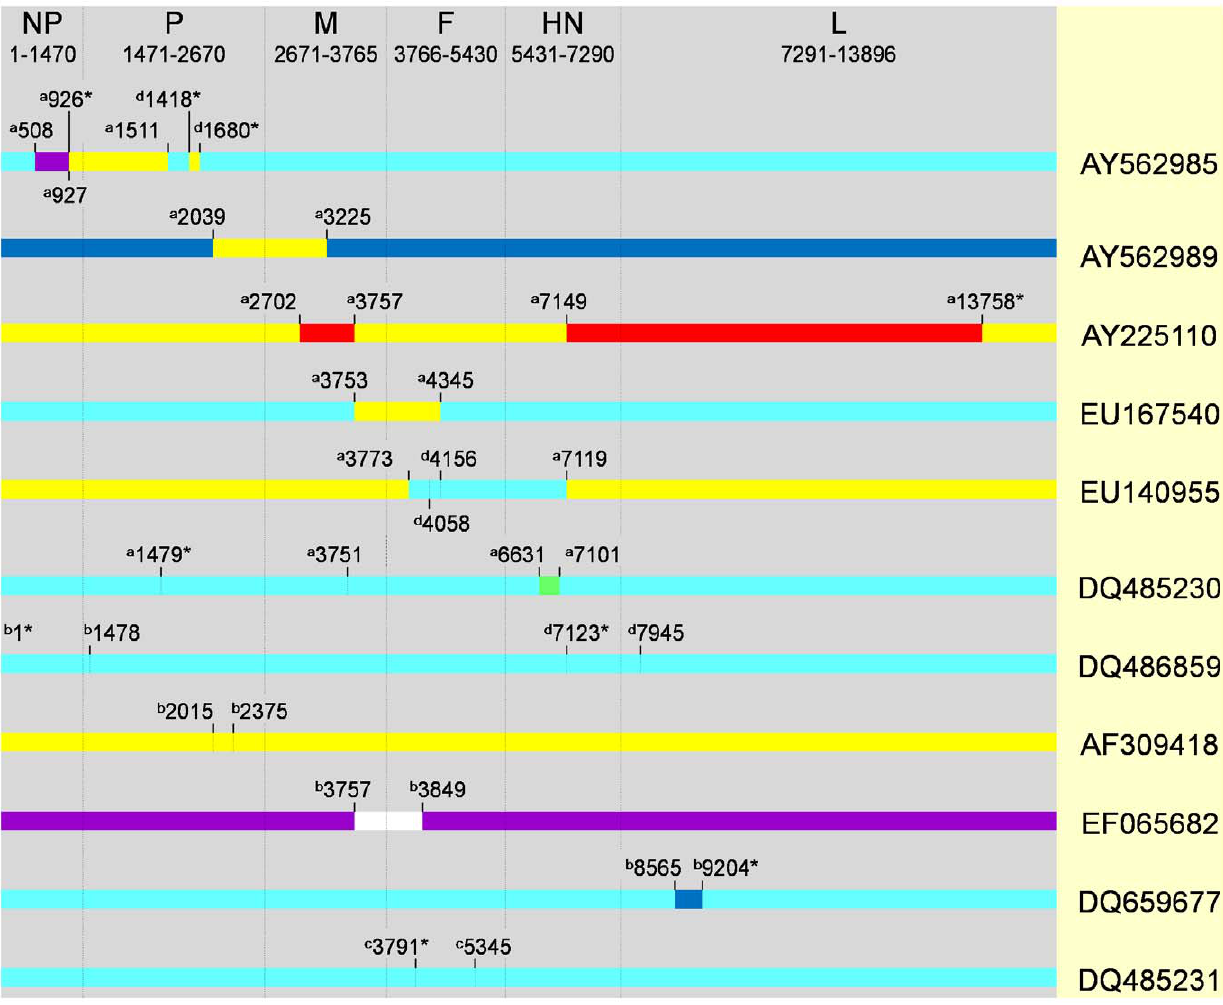
Figure 2. Recombination breakpoint map of eleven isolates detected by different methods implemented in RDP3 program. The nucleotide position of breakpoints in the concatenated genome is indicated. Regions that correspond to different genotypes are shown using the color scheme described in Figure 1. Superscripts a and b indicate statistical support (p-value # 10 2 5 ) from 5 or 3–4 methods, respectively. Superscripts c and d indicate statistical support (p-value # 10 2 3 ) from 2 to 4 or 1 method, respectively. Asterisk indicates that breakpoints could not be identified. Genes are not drawn to scale.